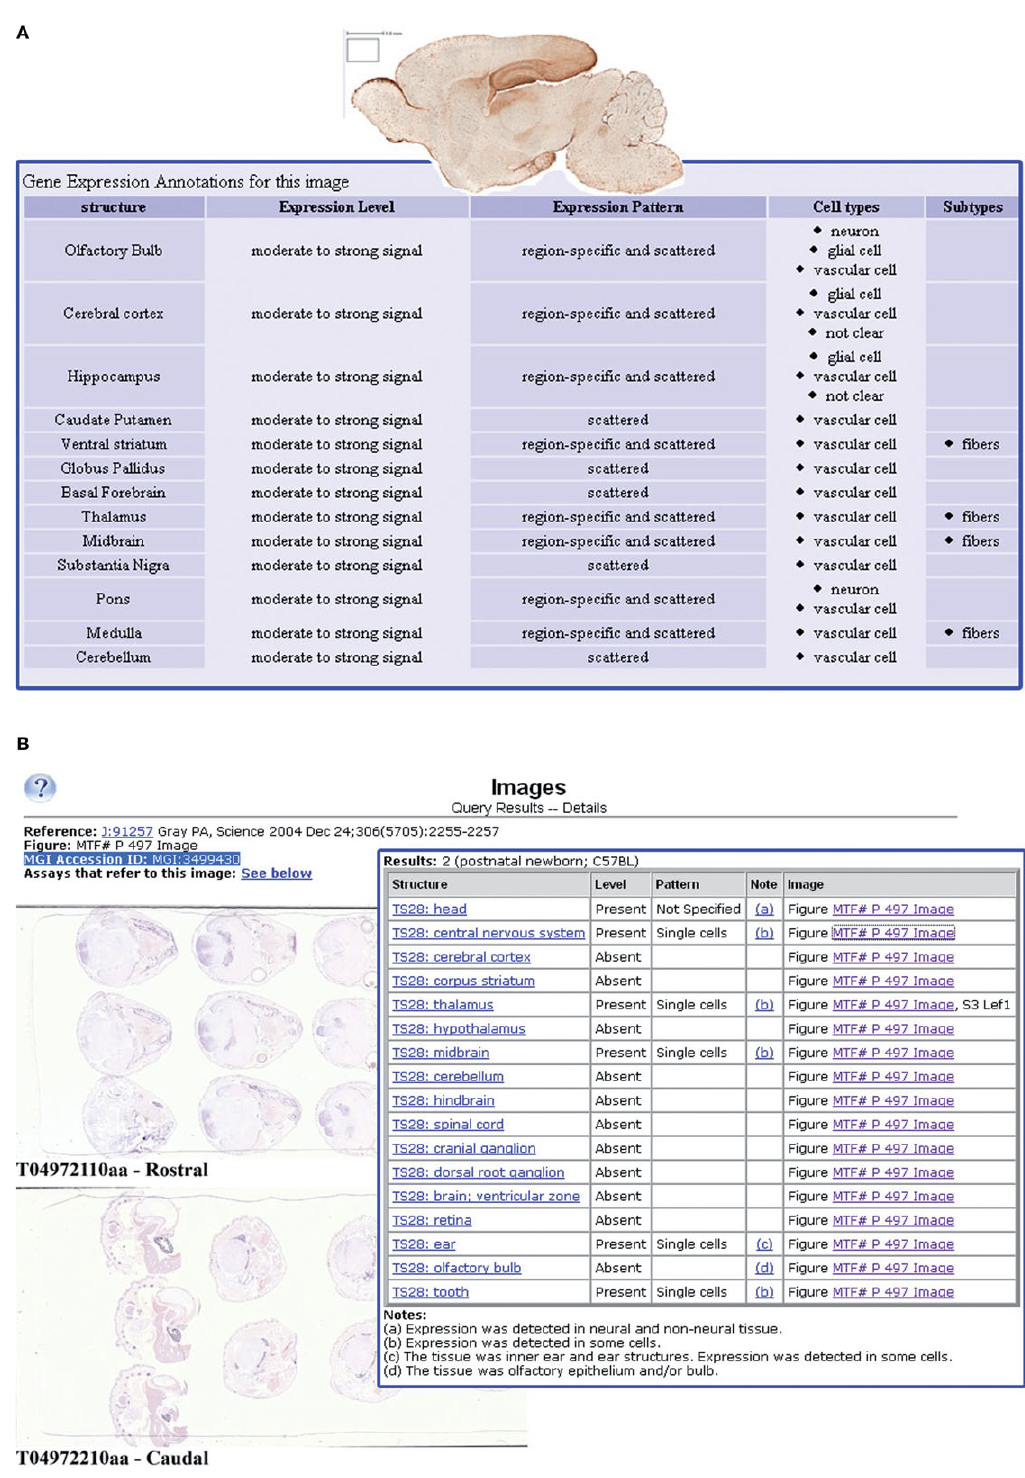
Figure 1 | Examples of databases which manage gene expression image without an anatomical framework. GENSAT and MGI both provide a rich repository of image data for gene expression. Neither uses a standard framework for data organization, rather, both describe the pattern and location of gene expression revealed by the image. GENSAT (A) describes the expression pattern for major structures in each image, while the MGI (B) summarizes a batch of assays (the MGI dataset shown here were used to derive the Lef1 gene examples shown in Lee et al., 2007). While these annotations aid interpretation, the ability to query or analyze these data in this format is very